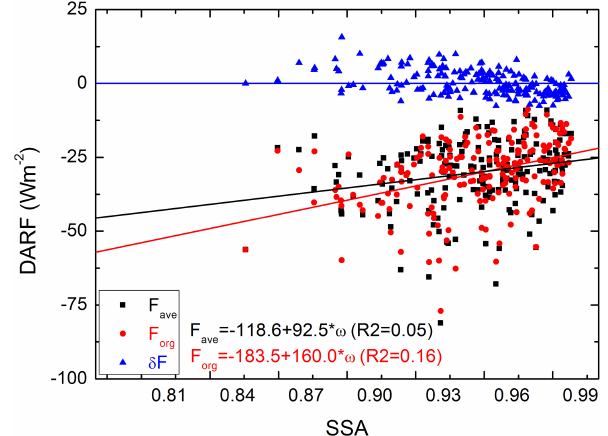
Figure 9. The same as the Fig. 8 but for SSA at 500nm.